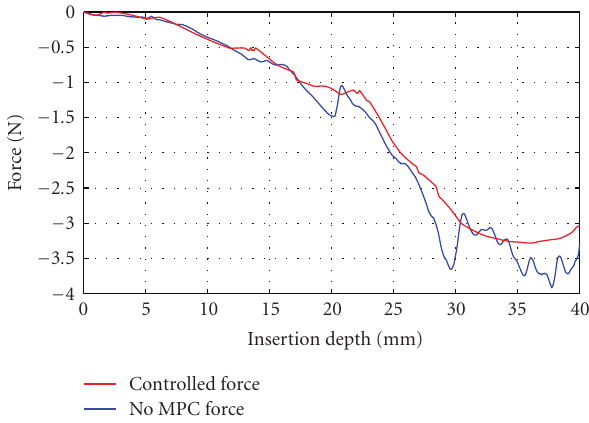
Figure 10: Controlled force (red) and insertion force when MPC is not implemented